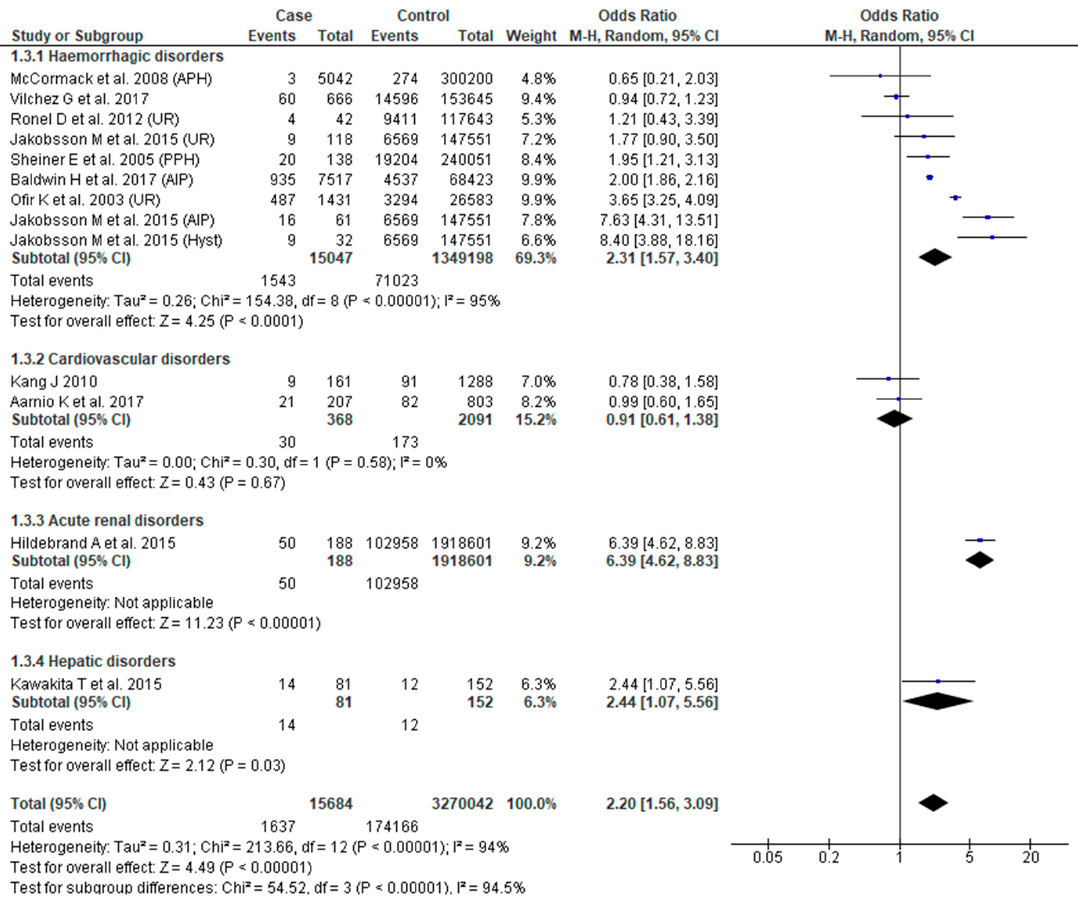
Figure 4. Forest plot of studies assessing association between Severe maternal morbidity (SMM) and low birth weight .